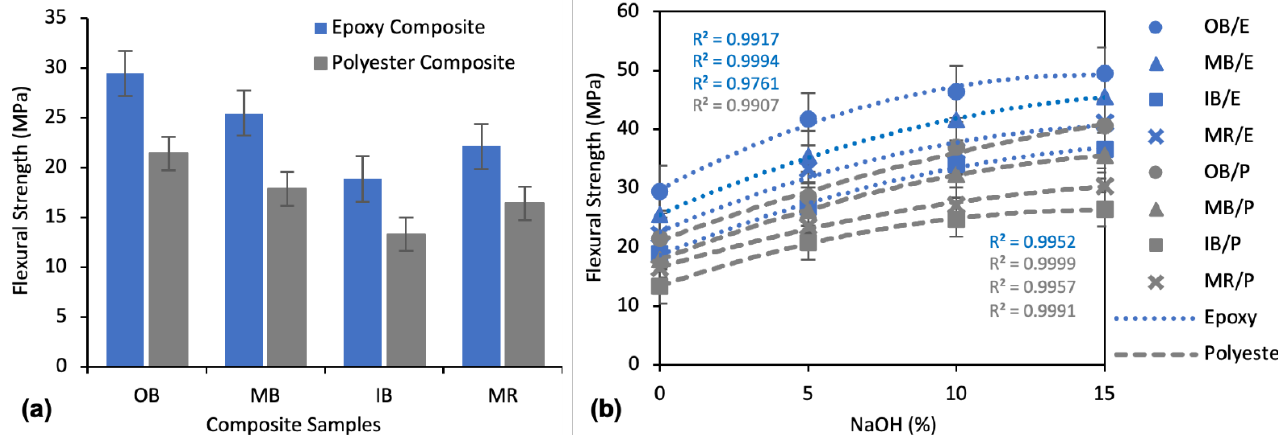
Figure 10. ( a ) Flexural strength of untreated (0% NaOH) composites; ( b ) Effect of alkali treatment on flexural strength of the composites.